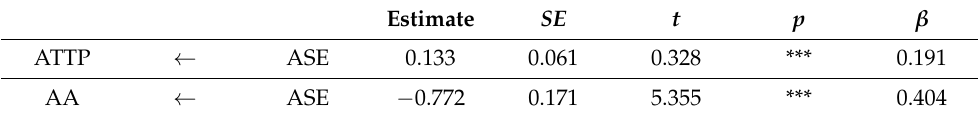
Figure 2. Final hypothesized model used in the research scenario. Table 7. Values of variance explained, standard error, t , p , and standardized regression